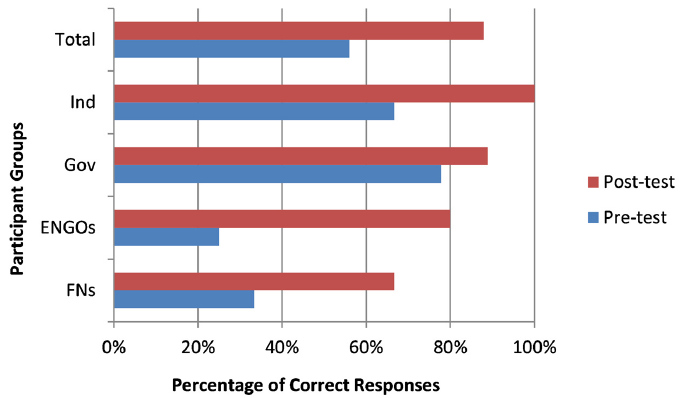
Figure 2. Participant familiarity with marker ‐ assisted selection (MAS) a priori interviews.